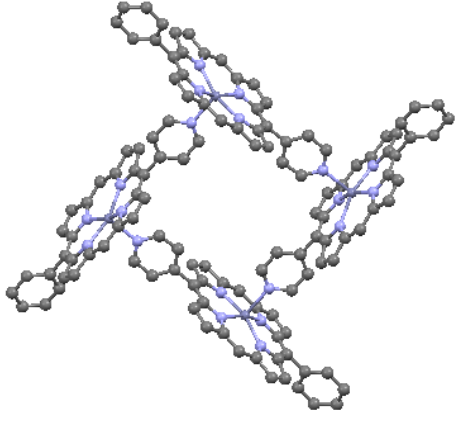
Figure 23. Porphyrin box structure, from data in [7,59]. Dark blue = Zn.